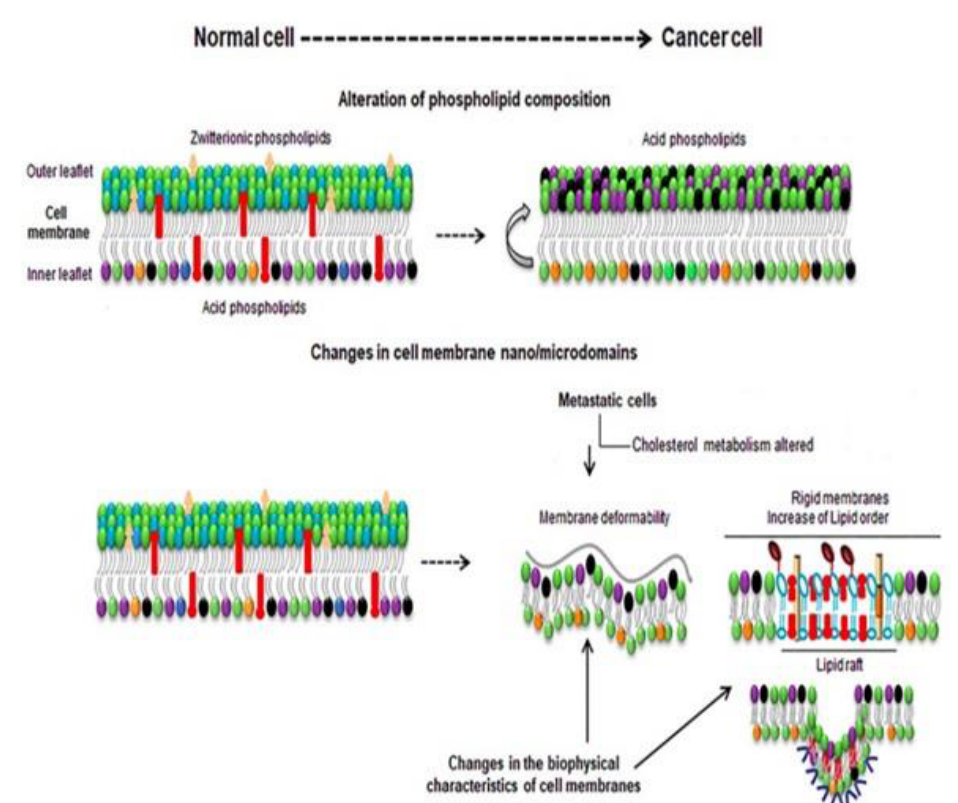
Figure 3. Composition and biophysical changes of a normal cell and cancer cell.